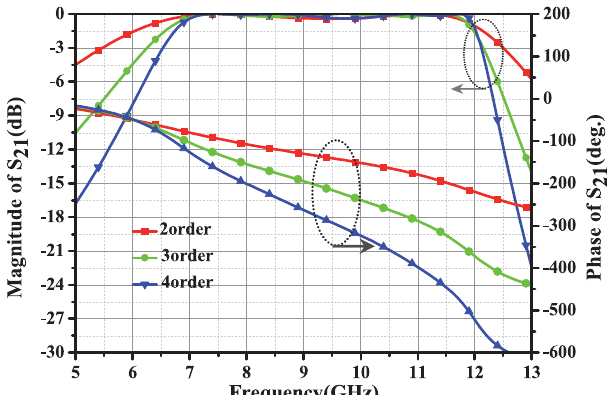
Fig. 3. The transmission magnitude and phase response curves of the second-order, third-order, and fourth-order